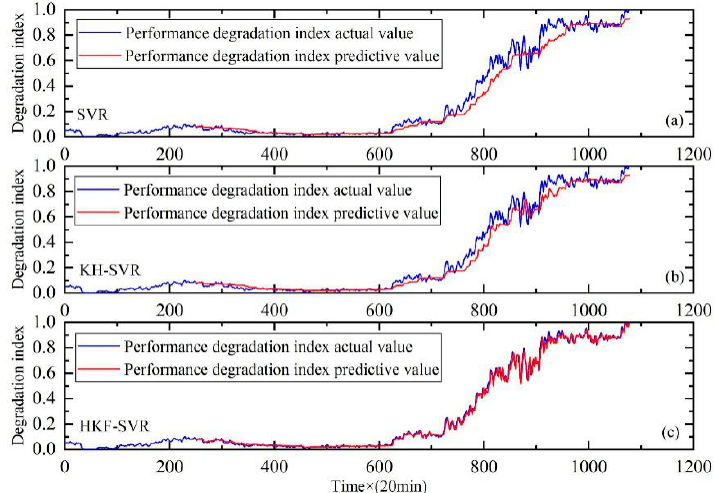
Figure 6. Performance degradation prediction of bearing 3. ( a ) is the result of SVR, ( b ) is the result of SVR with parameters optimized by the KH algorithm and ( c ) is the result of HKF–SVR with parameters optimized by the KH algorithm.